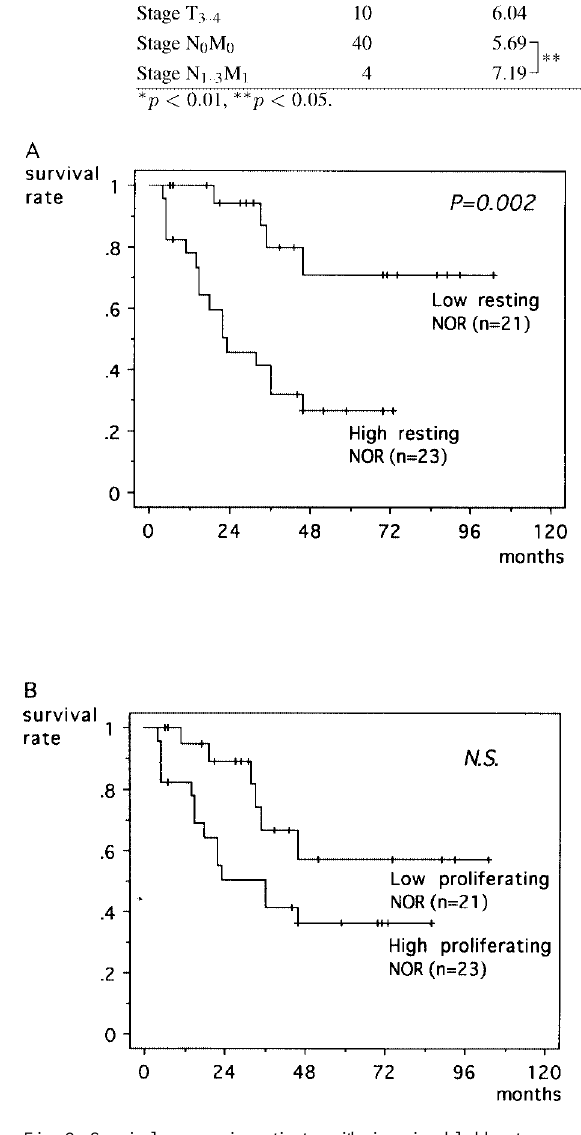
Fig. 2. Survival curves in patients with invasive bladder tumor. Higher survival rate is observed in patients with a low resting NOR tumor compared with those with high resting NOR tumor ( p = 0 . 002) (A). No significant difference is observed in survival rate between the high proliferating NOR group and the low prolifer- ating NOR group (B).